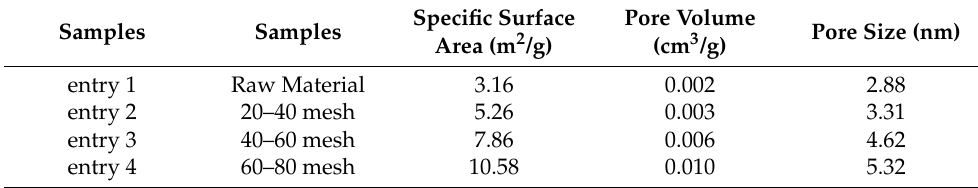
Table 1. The data of the BET